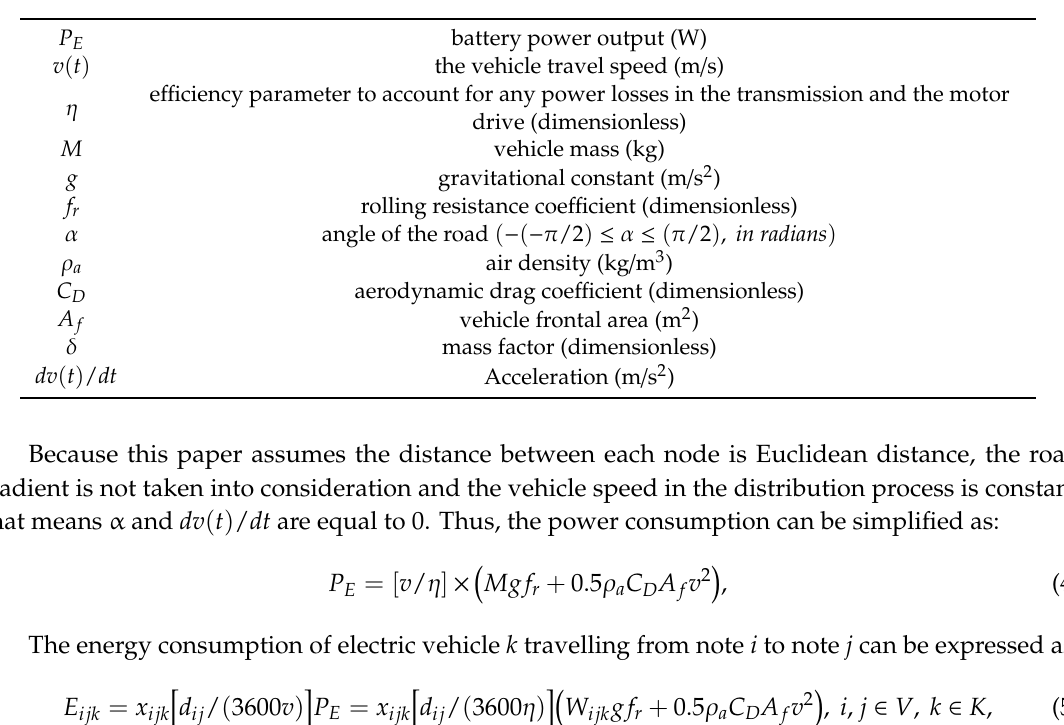
Table 2. The description of symbols in formula